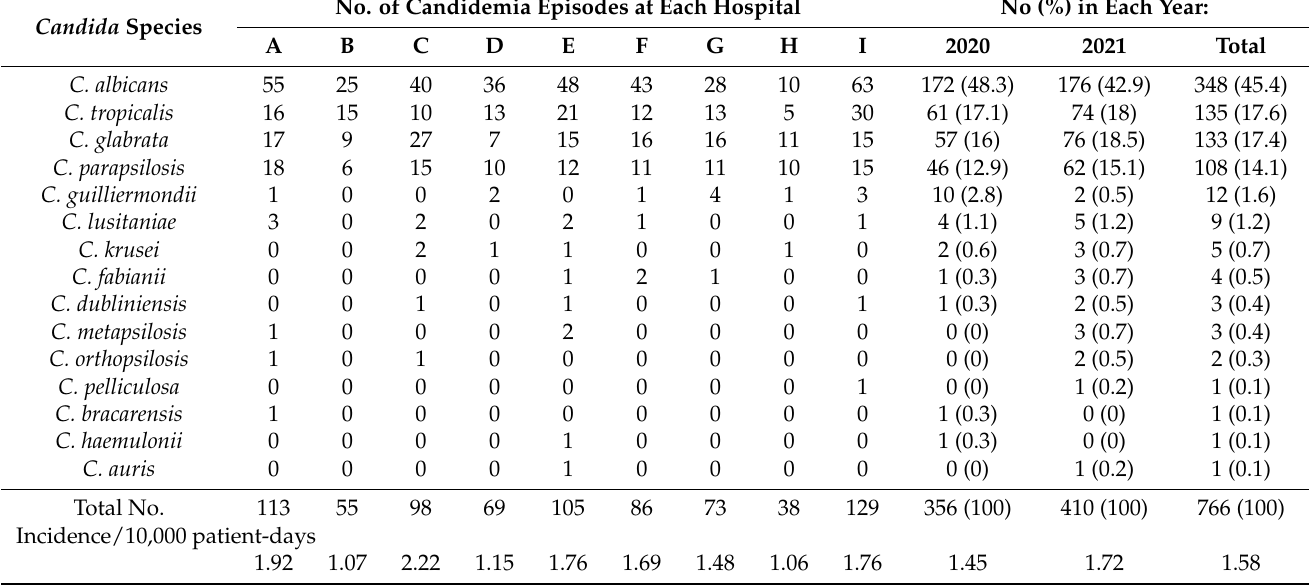
Table 1. The incidence of candidemia collected from Kor-GLASS surveillance system during the two-year